Question: In a single sentence, describe what this figure presents.
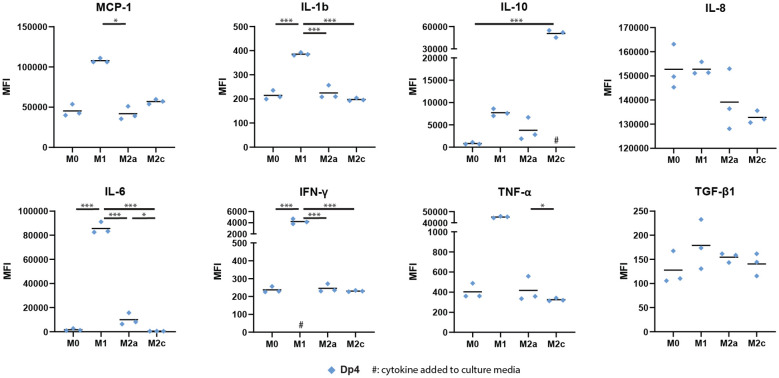
Answer: Protein expression of polarized macrophages. Cytokine/chemokine measurements using the LEGENDplex™ assay on medium from M0, M1, M2a, or M2c polarized macrophages. For each replicate, two wells were pooled into one sample, with three samples (i.e. n=3 replicates) for donor pool 4 (Dp4). Mean fluorescence intensity (MFI) shown with line as mean. # denotes samples where the specific cytokine was present in the polarization media. * p < 0.05, *** p < 0.001.